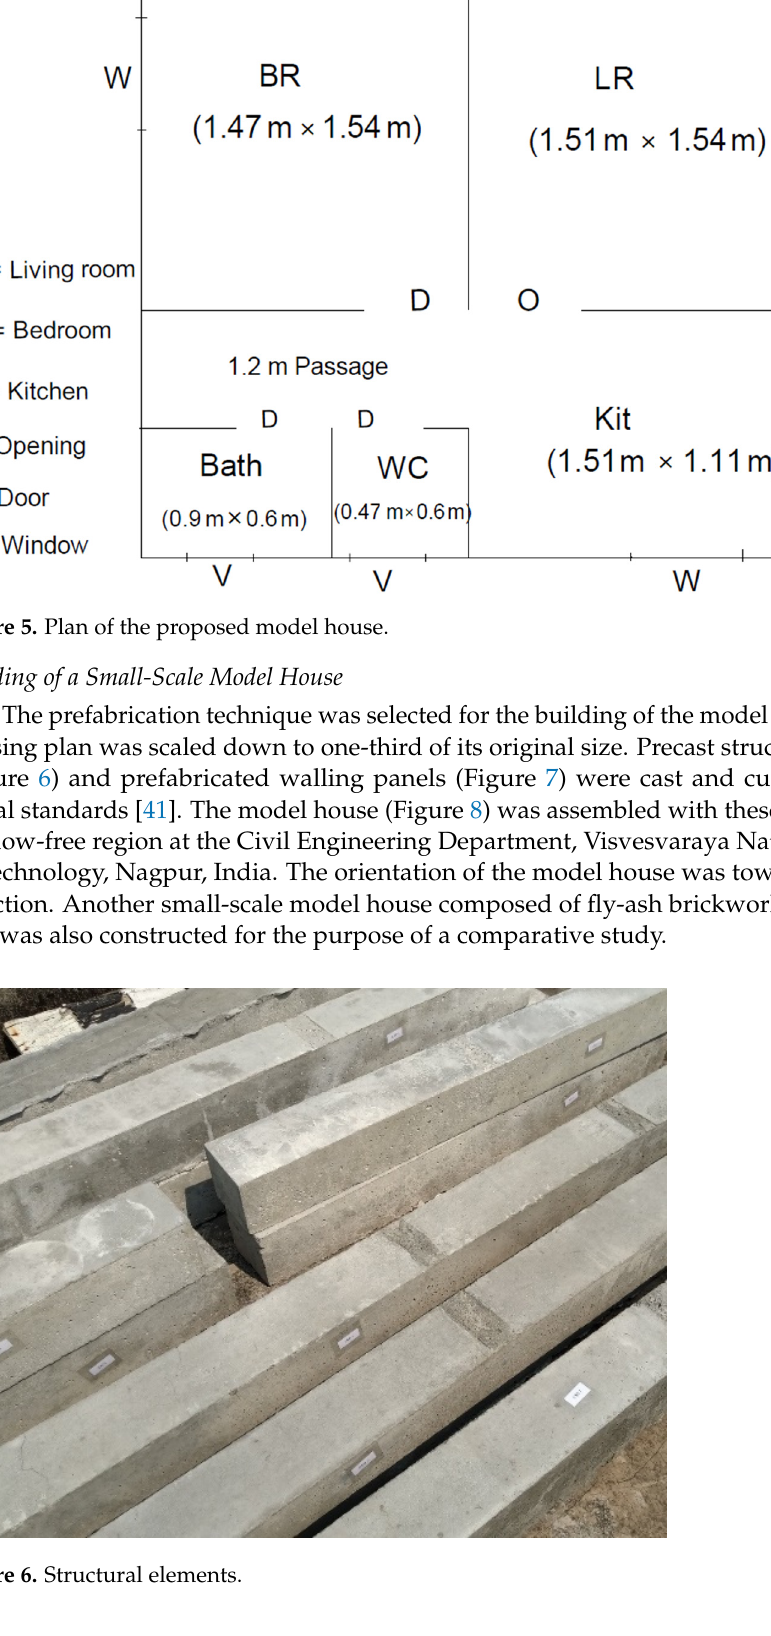
Figure 6. Structural elements.